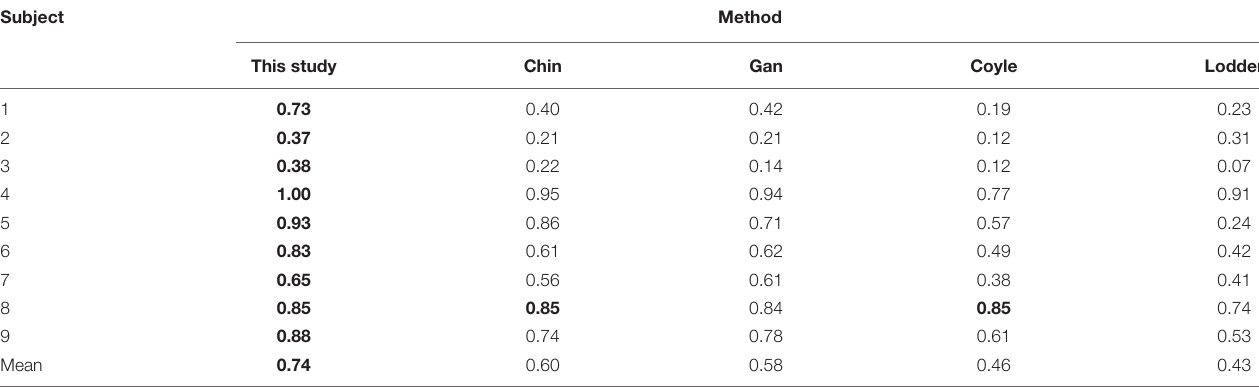
TABLE 6 | Comparison of kappa values on data set 2 between the methods proposed in this study and the methods adopted by the top four in the BCI competition.